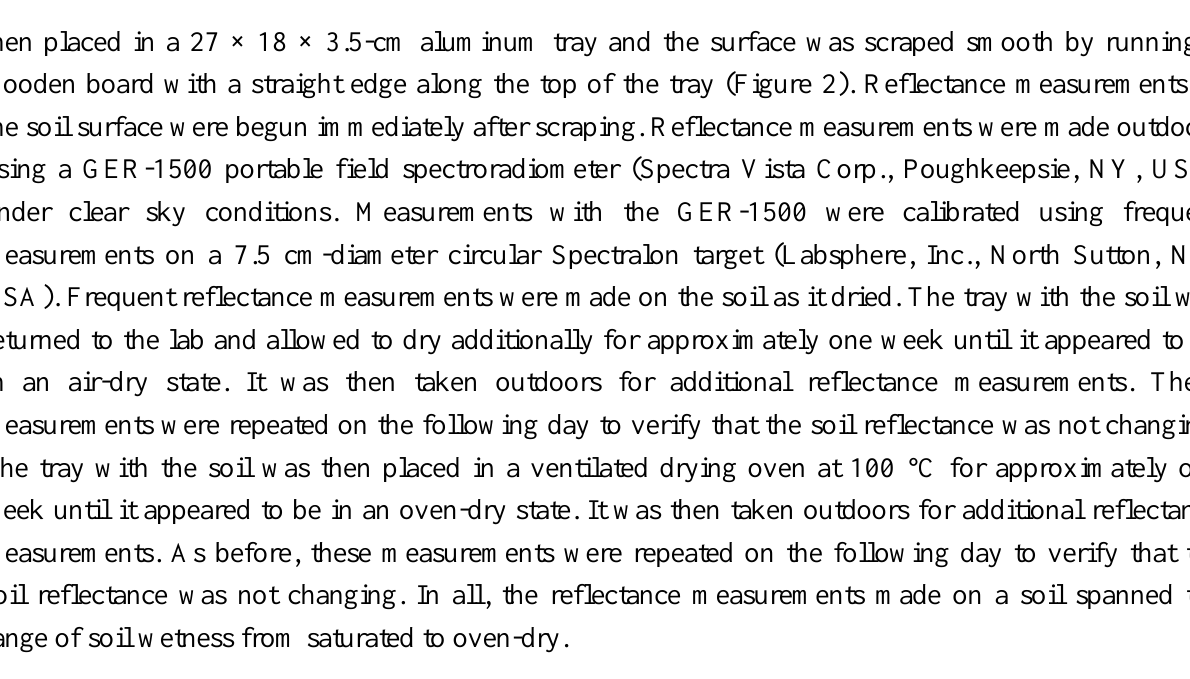
Table 1. Characteristics of the seven soils used in the study.